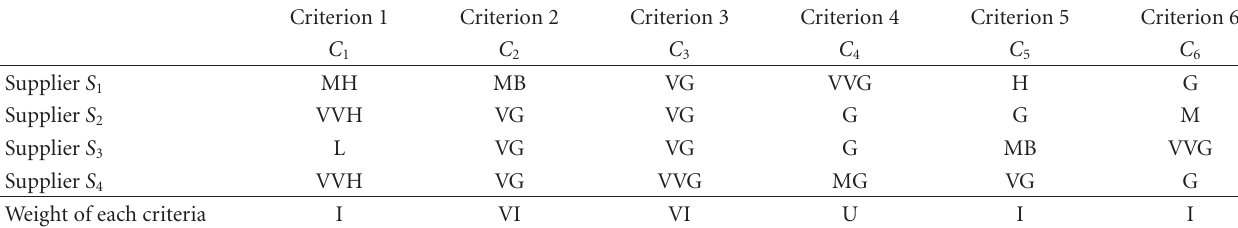
Table 7: Rating of the alternatives from decision maker 3 (DM 3 ).